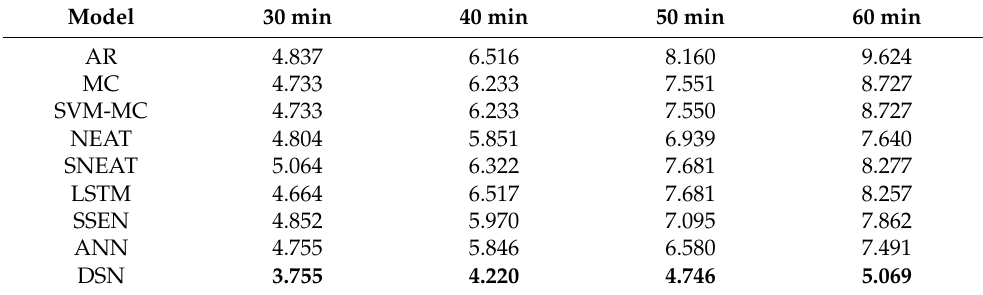
Table 3. MAE of different models at different forecasting horizons over the whole year 2010.